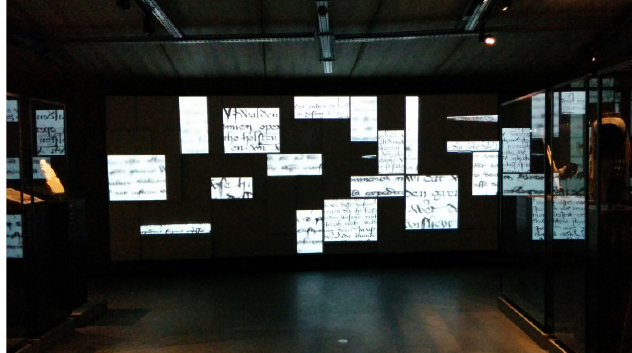
Figure 16. Dynamic audio-visual projection of forms and colours based on fragments of artefacts and old manuscripts. Danmarks Borgcenter, Vordingborg, Denmark. Photo: The